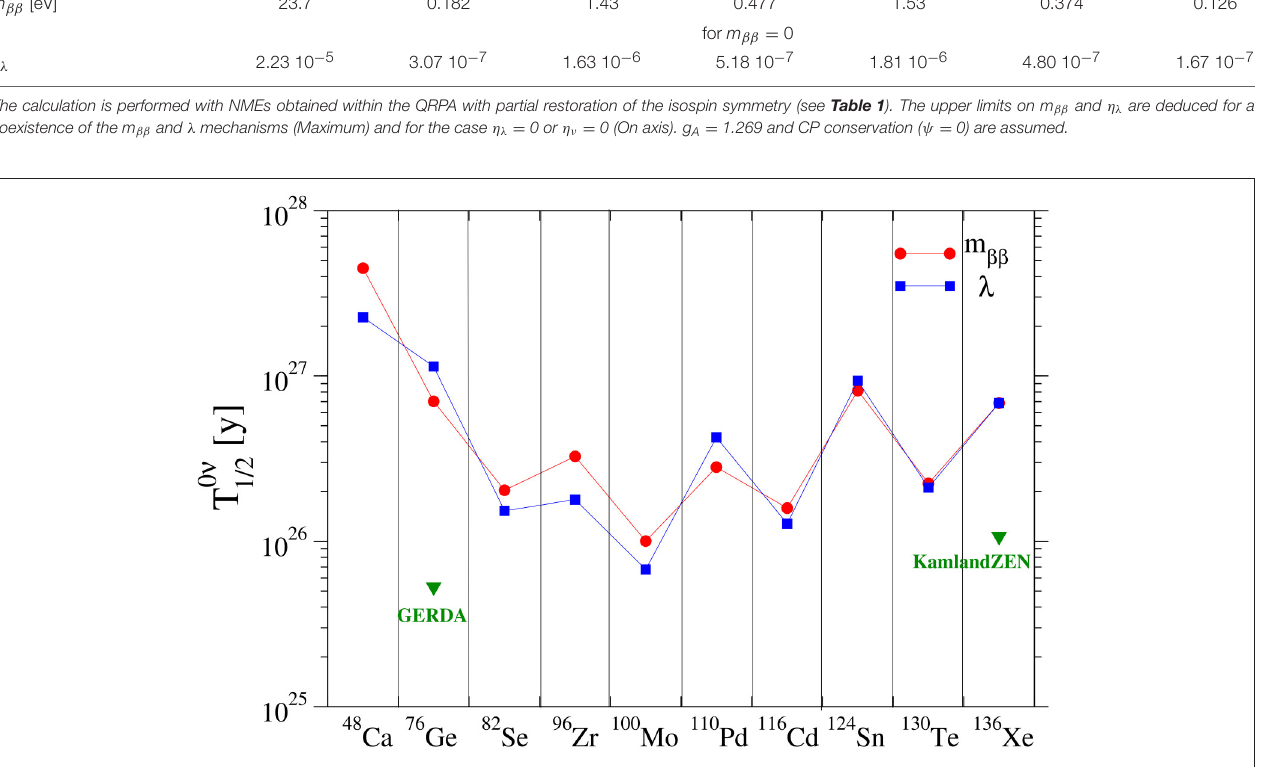
6.86 10 26 years ( m ββ 50 meV or η λ 9.8 10 − 8 ). The current experimental limits on 0 νββ -decay = = =